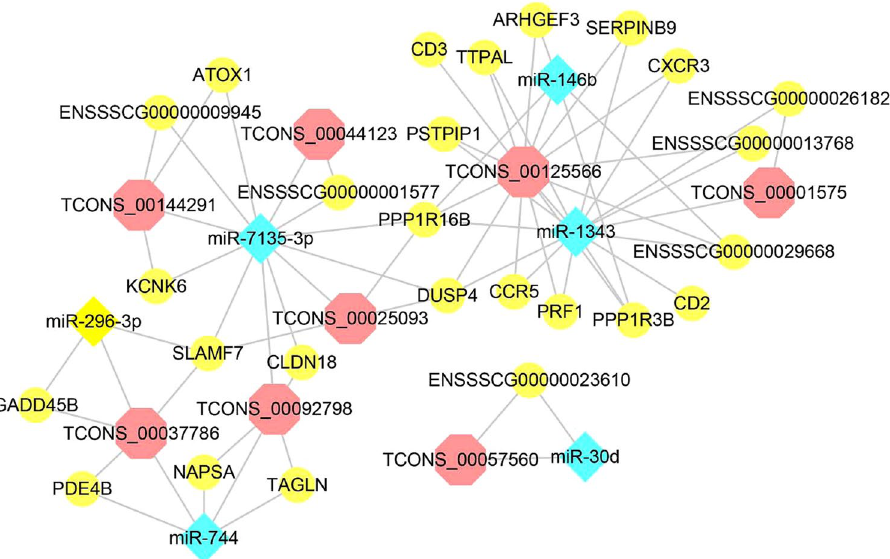
Figure 7. Regulatory network of lincRNA-miRNA-mRNA.